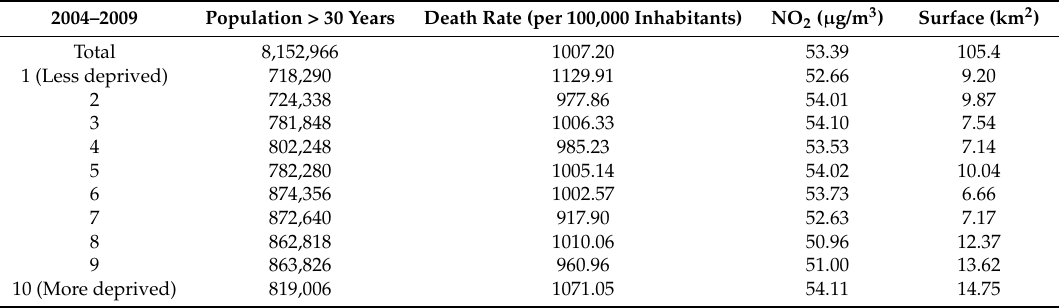
Table 1. Descriptive statistics by socioeconomic deprivation class over the period 2004–2009. It corresponds to the input data of the health impact assessment (HIA) for NO 2 exposure,